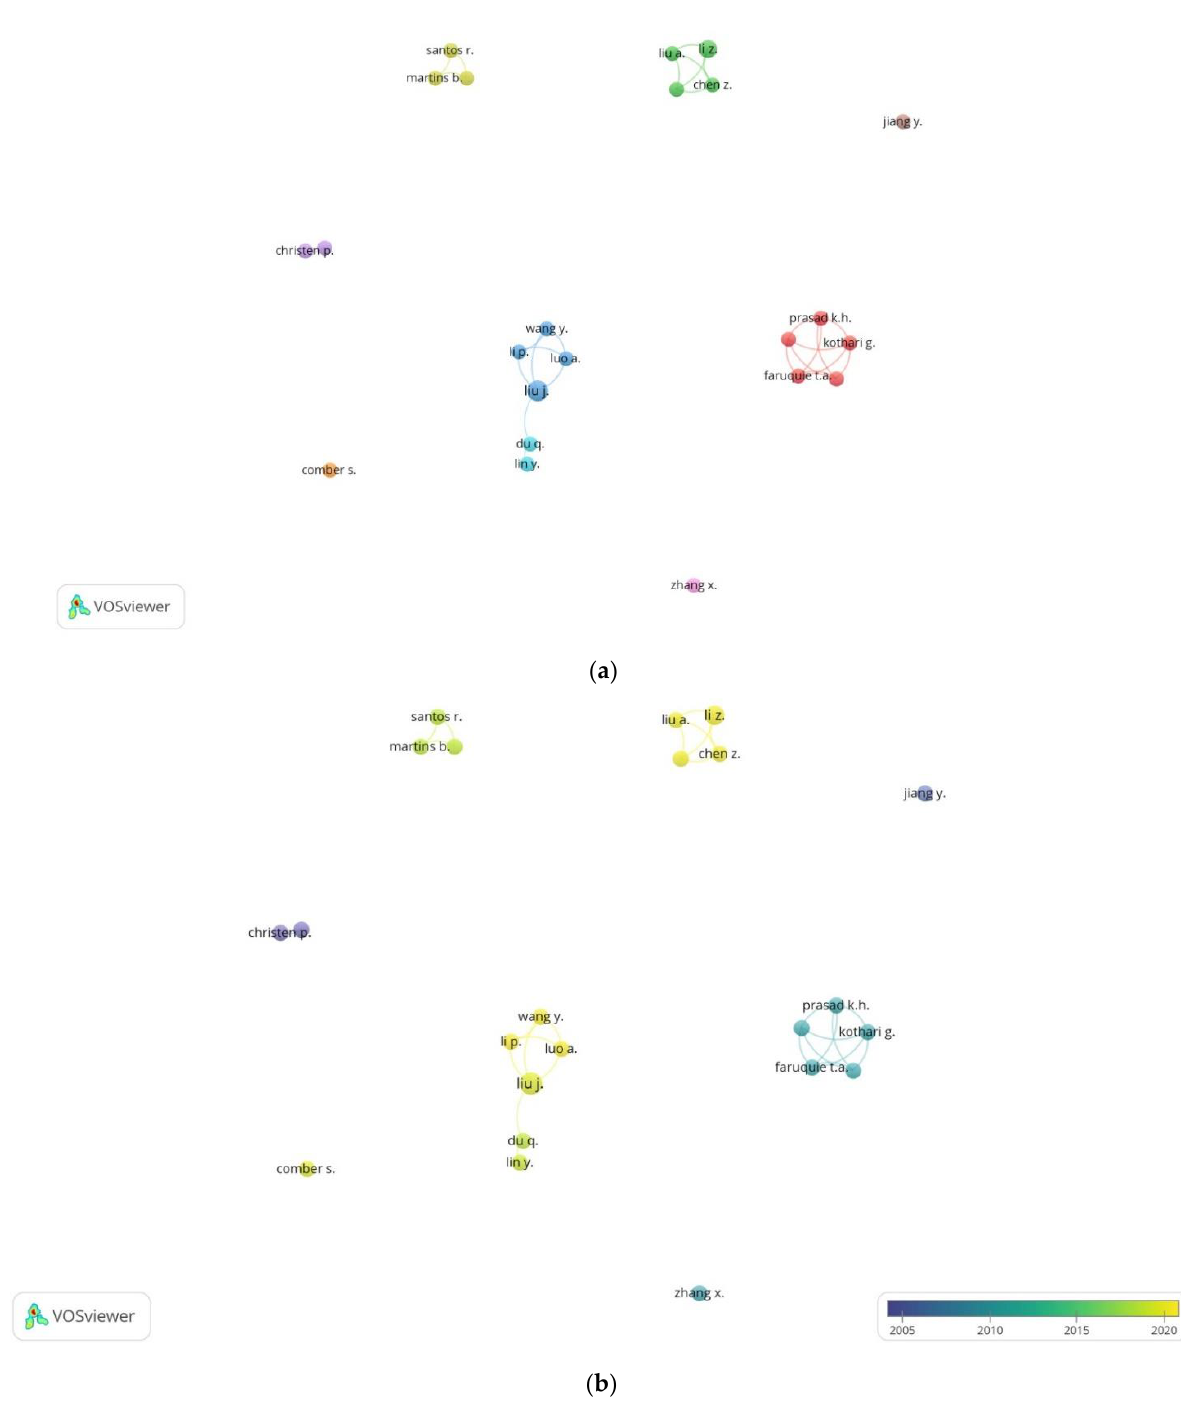
Figure 5. ( a ) Network visualization of author co-authorship analysis. ( b ) Author co-authorship analysis by year overlay visualization. Note: An author’s name is represented by a circle and its importance by the circle’s size, with circles of the same color belonging to the same cluster. The thickness of the link connecting the circles represents the number of times two connected nodes are mentioned together. An earlier time is represented by a color closer to blue and a more recent year by a color closer to yellow.